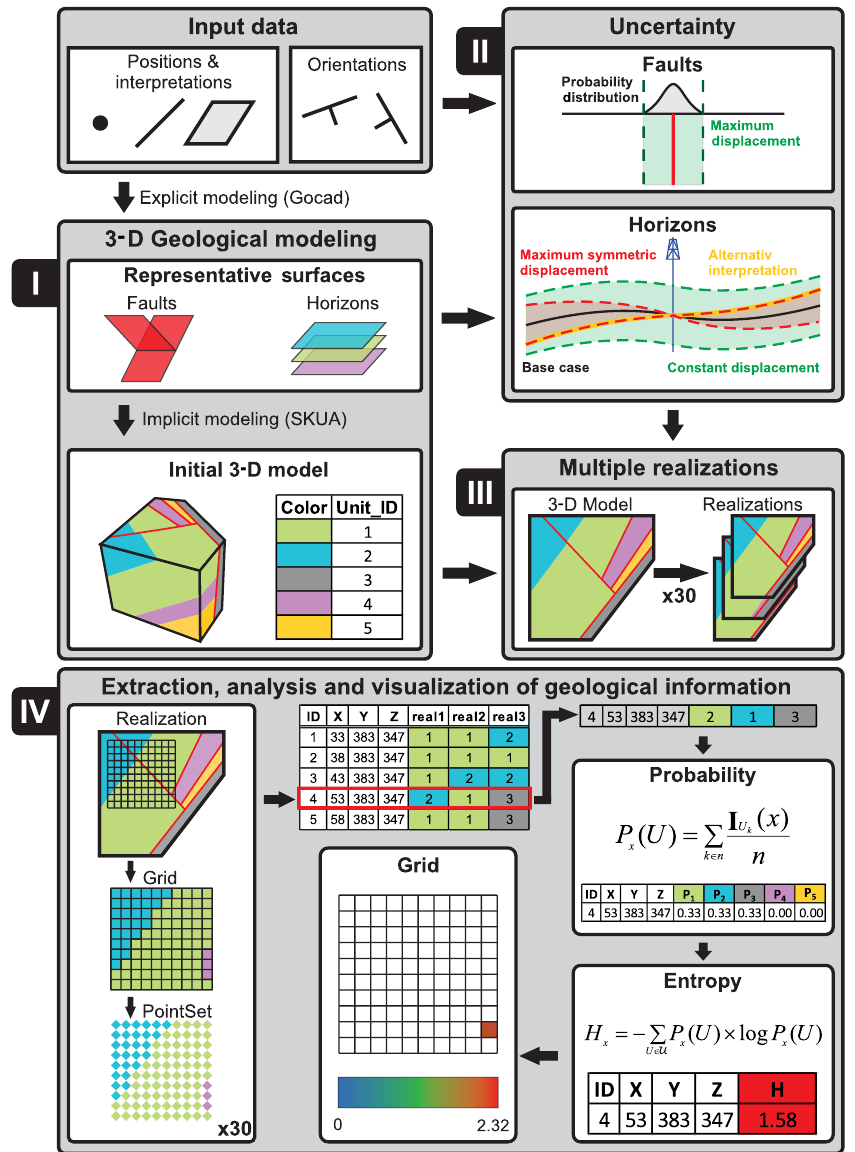
Figure 4. Uncertainty assessment workflow with four distinct steps. This workflow is applied to four initial models that are based on the different data sets illustrated in Fig.